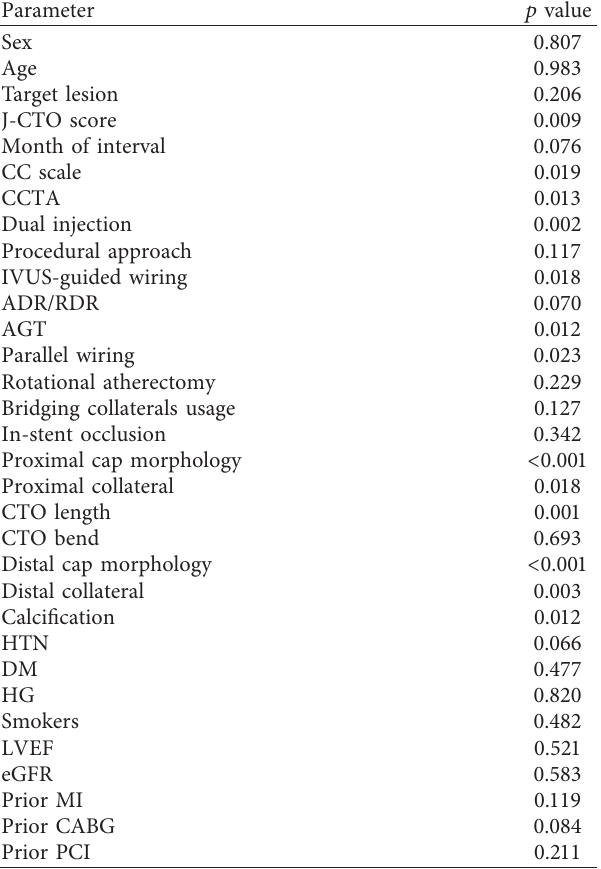
Table 6: Multivariable logistic regression